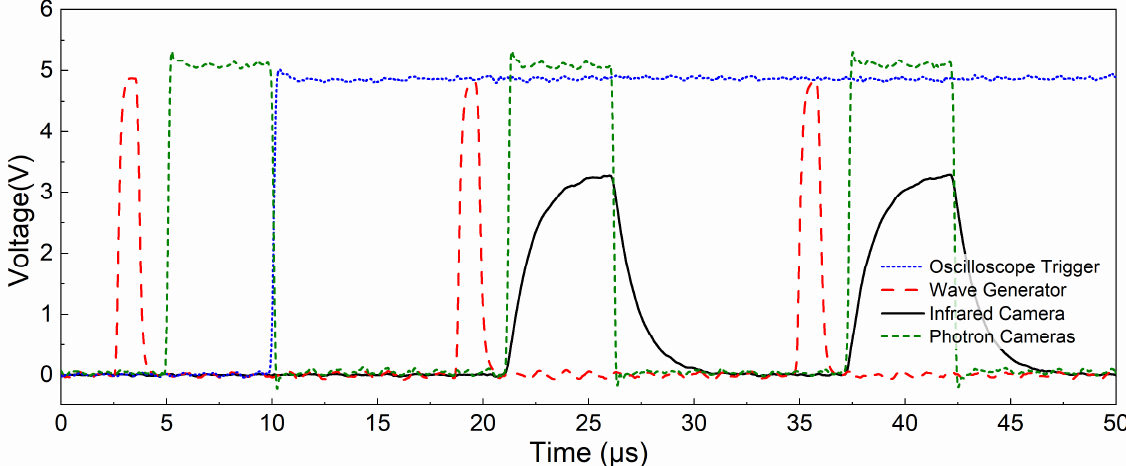
Figure 8. Oscilloscope trigger, wave generator signal, infrared, and optical camera trigger-out signals as a function of time at the moment of the trigger event. The overlapping of the infrared and Photron camera signals show the synchronization of image acquisition after the oscilloscope sends its trigger signal.